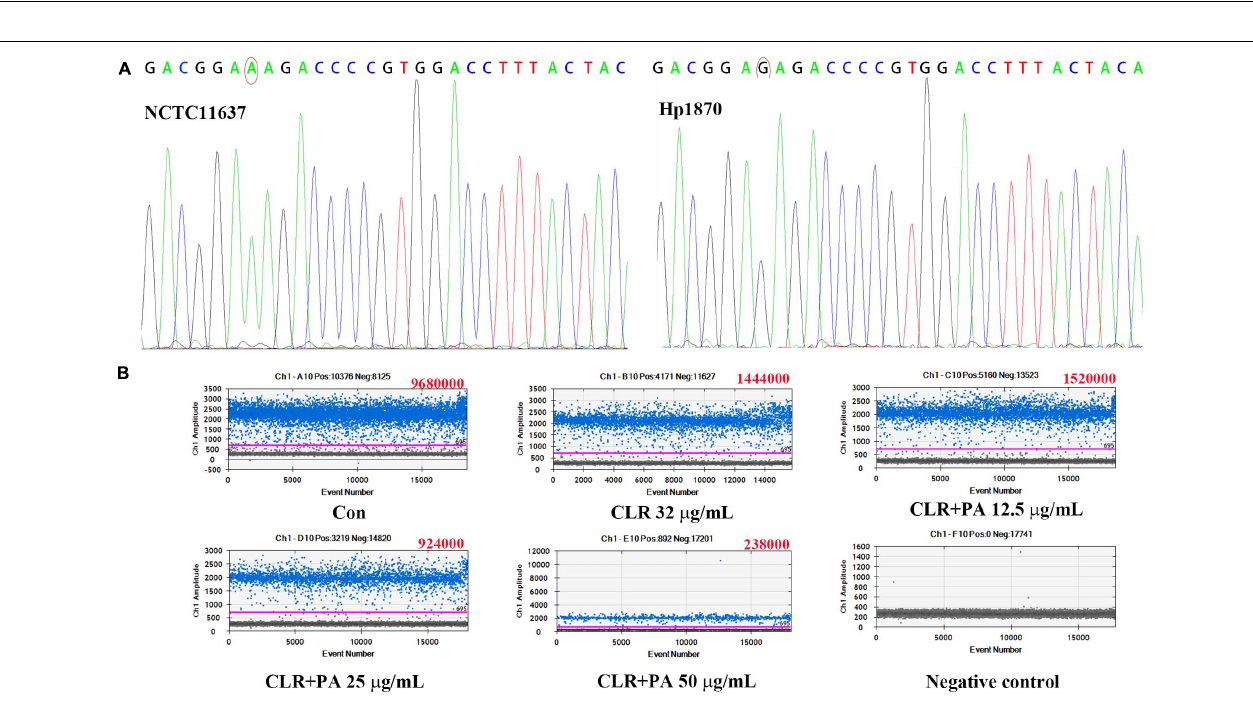
FIGURE 6 | Expression of efflux effect gene. (A) Expression of different efflux effect homolog genes of Hp1870 after being incubated with DMSO, CLR, and PA. (B) Expression of hp0605 after being stimulated with different doses of CLR and PA for different times. The results are expressed as the mean ± SD ( n = 6). * P < 0.05 and ** P < 0.01, compared with the results for the control group; # P < 0.05 and ## P < 0.01, compared with the results for the model group.